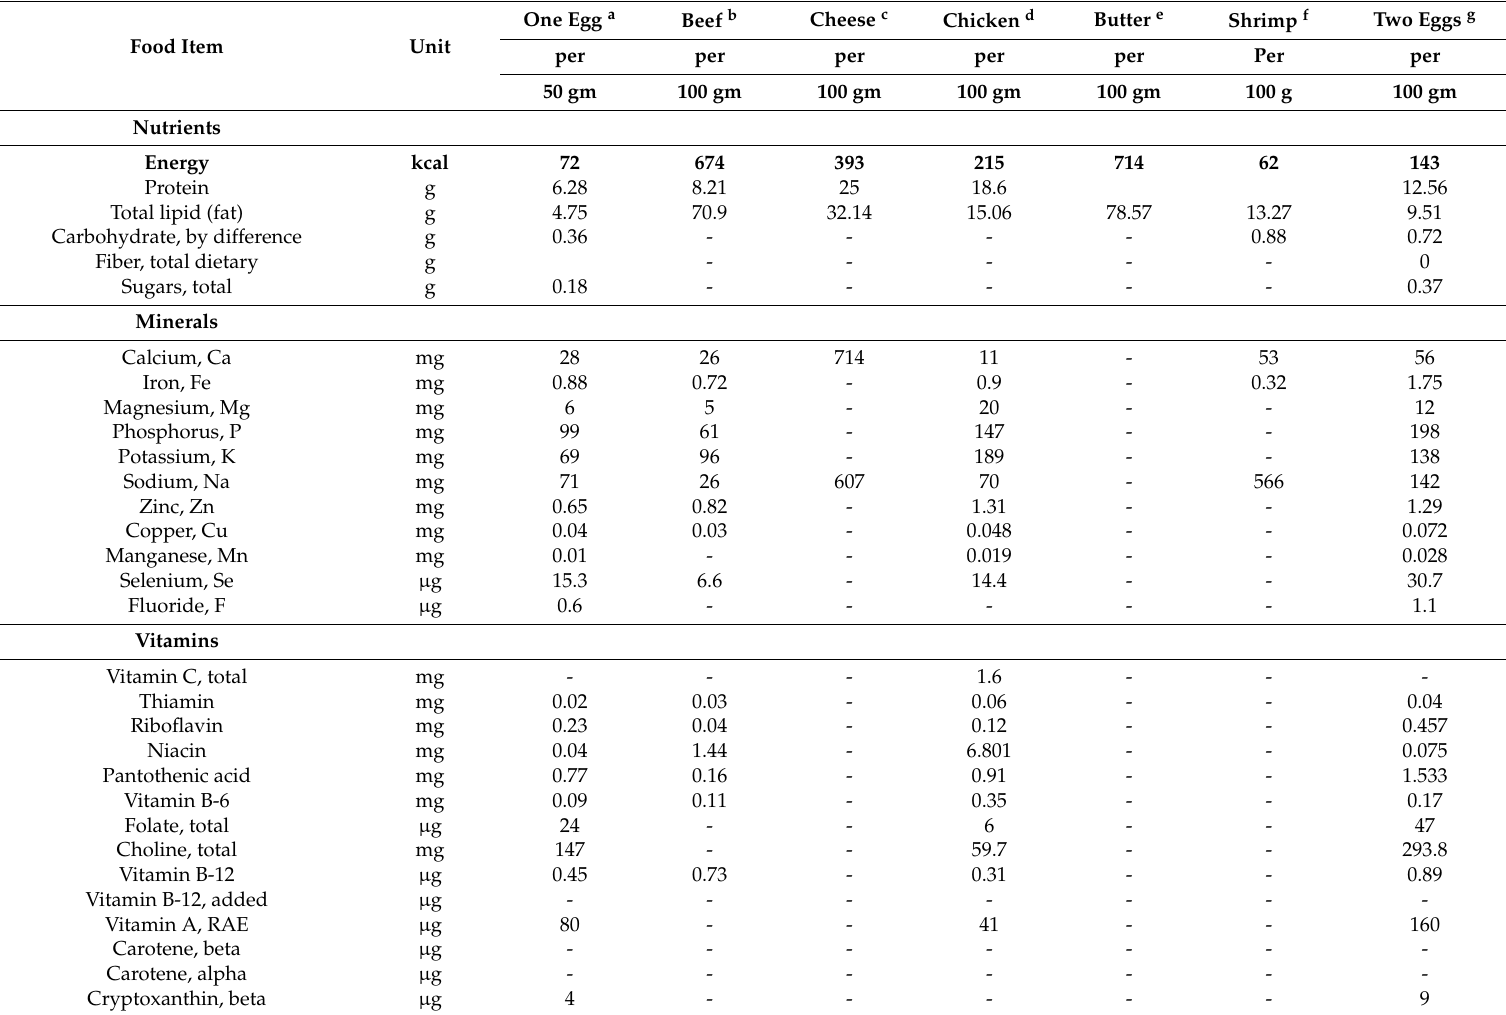
Table 1. Nutrient Composition of Most Commonly Consumed Cholesterol-Containing